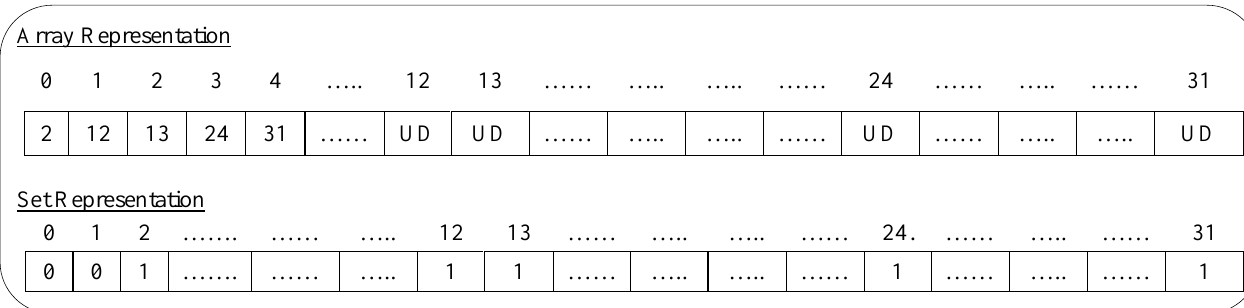
Figure 1. Array and Set Representation of the itemsets I = {2, 12, 13, 24, 31}.